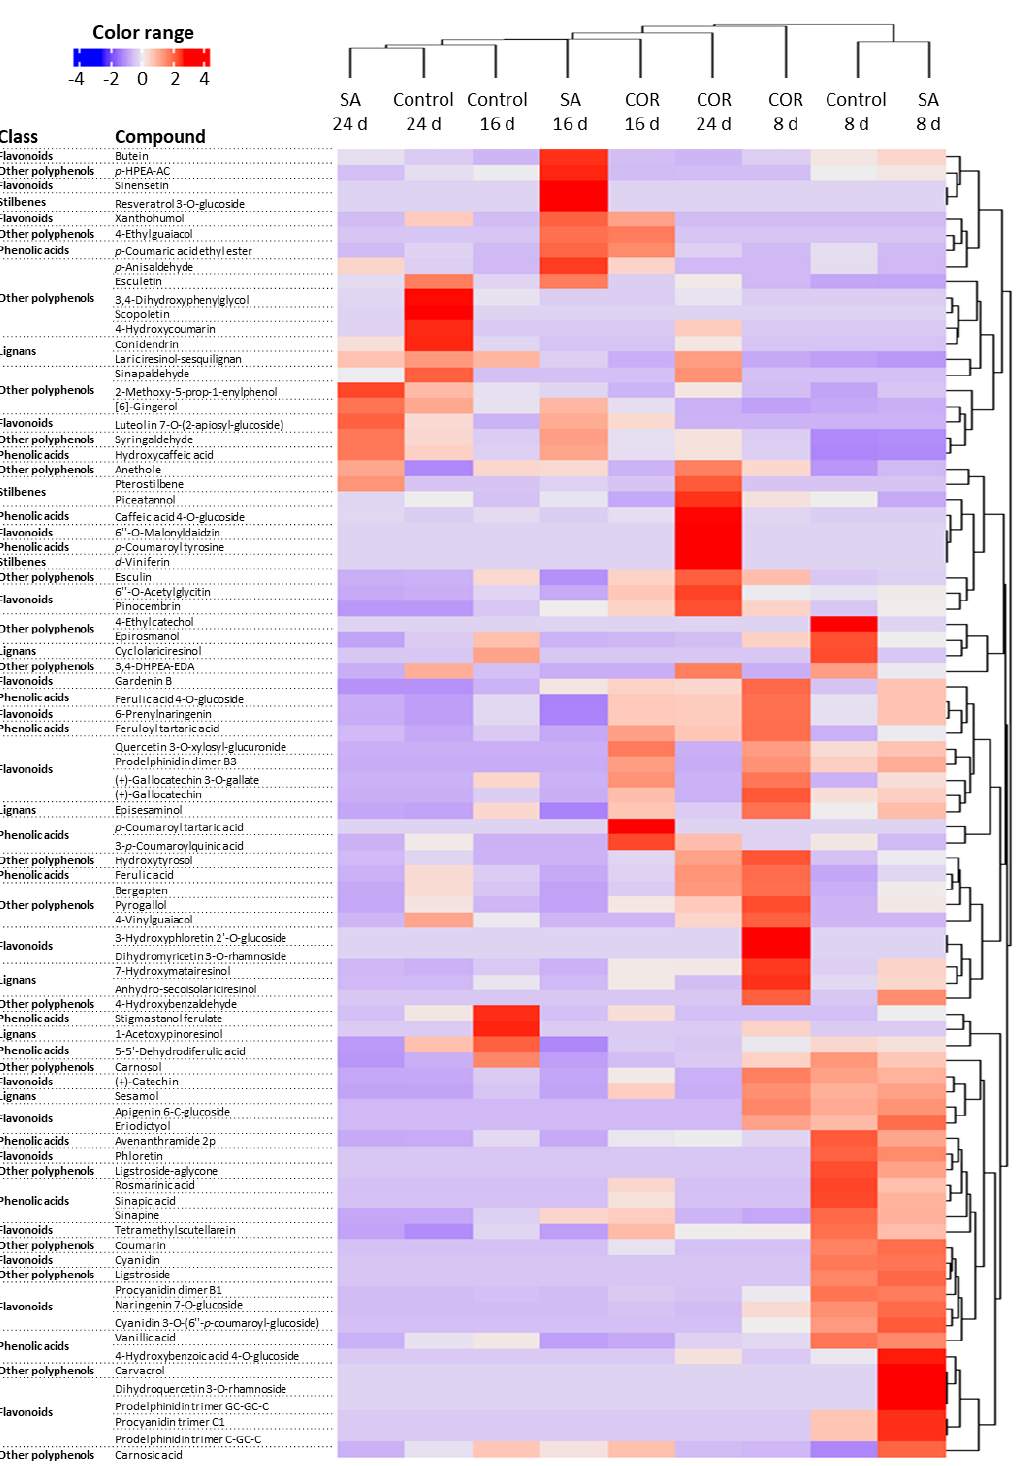
Figure 1. Unsupervised hierarchical cluster analysis on extracts from T. baccata cell suspensions either untreated (control) or elicited with 1 μM coronatine (COR) or 150 μM salicylic acid (SA), at different experimental time points (days 8, 16, and 24). The heatmap is based on the average values of phenolic compounds, and the data were preprocessed by autoscaling (unit variance scaling, UV). Clustering was performed according to averages algorithm and based on Euclidean